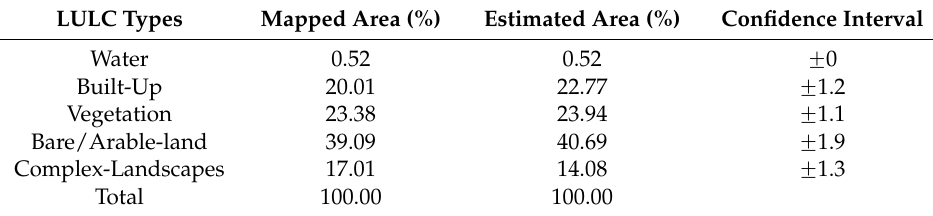
Table 8. Proportion of LULC category for 2001.